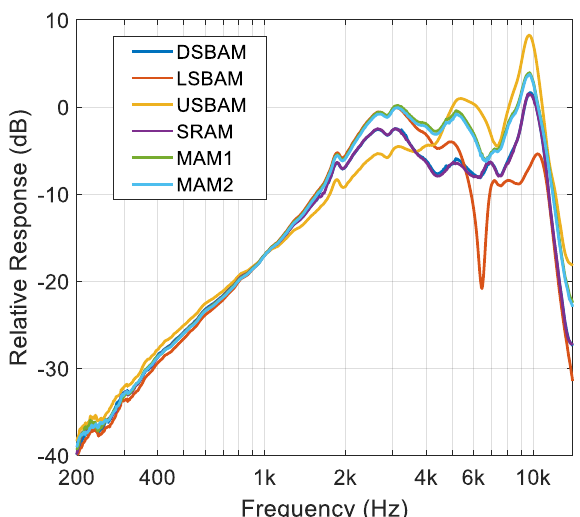
Figure 5. Transfer functions measured with different preprocessing techniques (modulation index m 2 = 1). 3